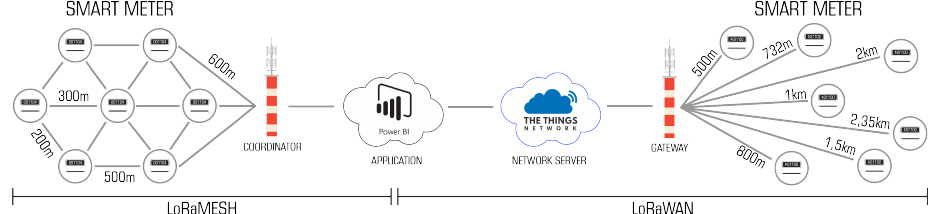
Figure 10. LoRaMESH and LoRaWAN